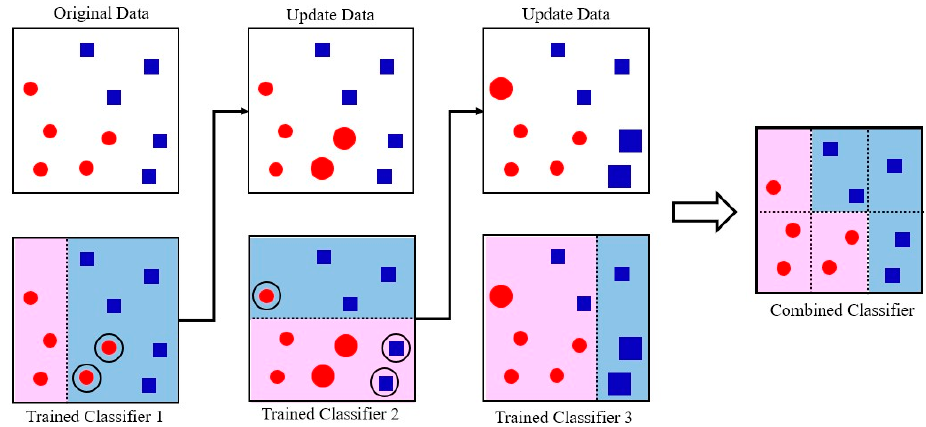
Figure 9. Learning structure of the gradient boosting machine.